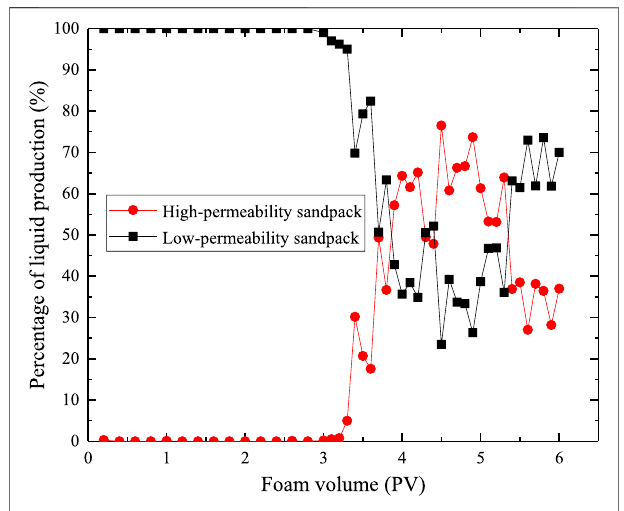
FIGURE 10 | Comparison of the ratio of liquid production of high- permeability/low-permeability sandpack to total liquid production.